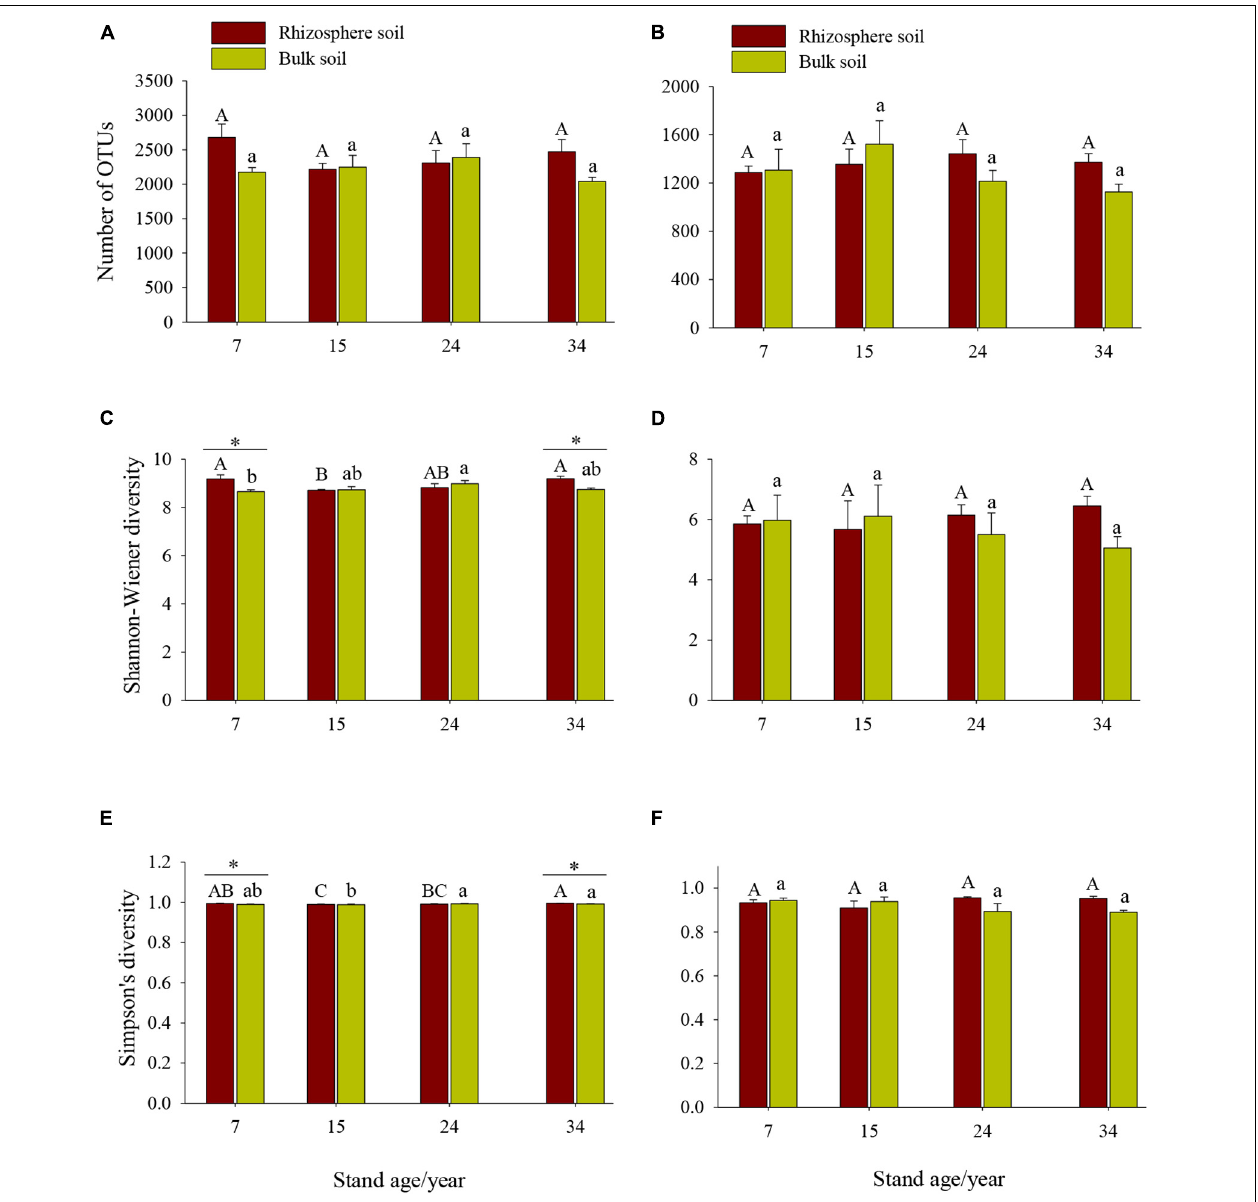
FIGURE 1 | Differences in bacterial (A,C,E) and fungal (B,D,F) alpha diversity among different stand ages in Xinkou Forest Farm, Southeastern China. Data are means ± SE ( n = 4). Different uppercase and lowercase letters represent significant differences ( p < 0.05) among different stand ages within rhizosphere and bulk soil, respectively; ∗ significant differences between rhizosphere and bulk soils based on a one-way analysis of variance (ANOVA) followed by a least significant difference (LSD) test ( p <